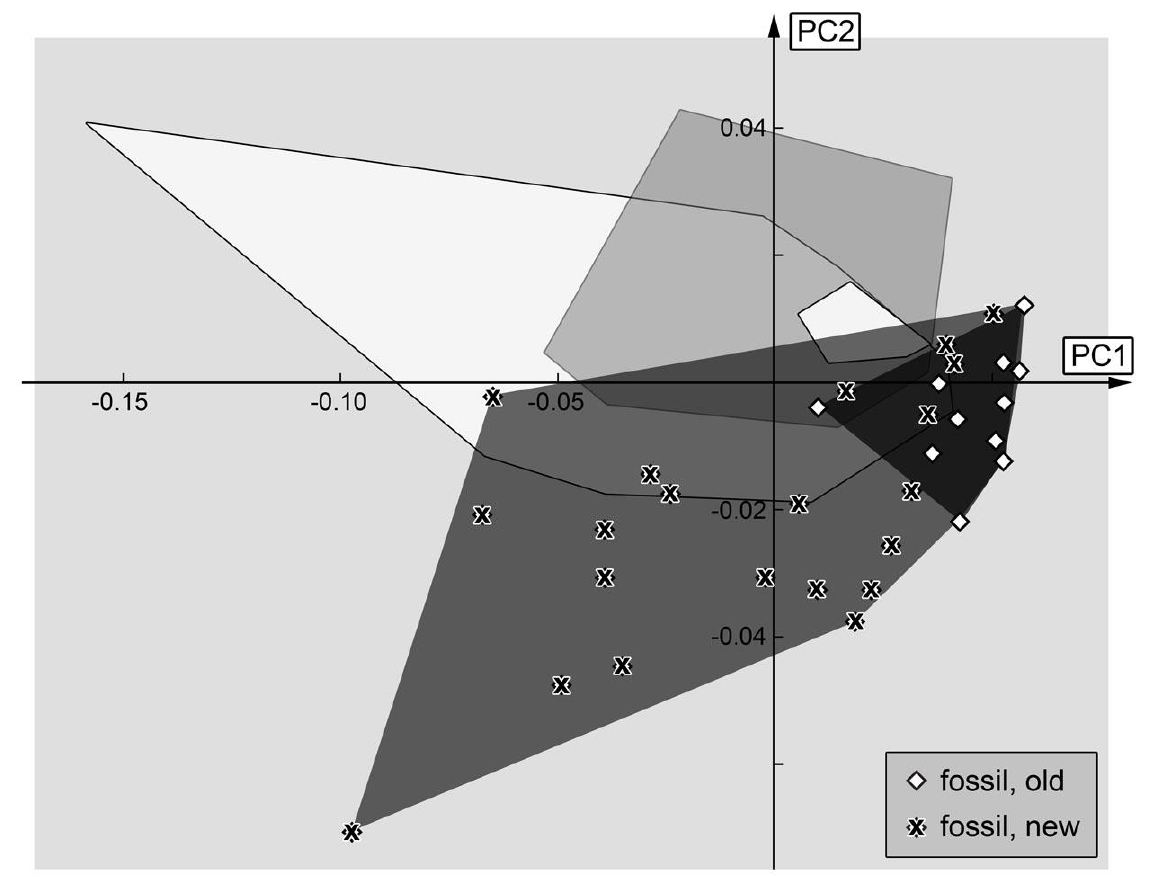
Figure 30. Same morphospace as in Figure 29, highlighting the new occupation of morphospace of the fossils.